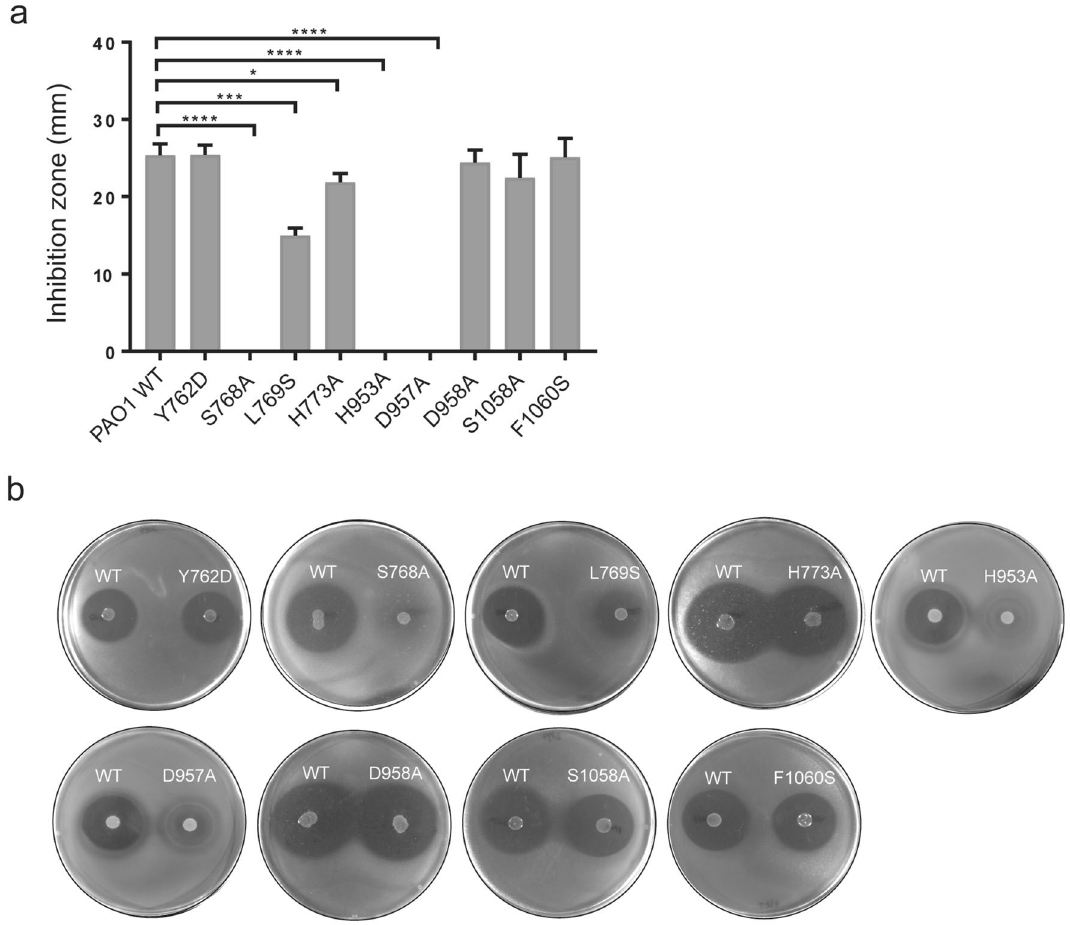
Figure 4. Plate inhibition assay for PAO1 WT and mutants against E. coli K12. ( a ) The diameter of zones of inhibition for PAO1 WT and mutants were measured using Image J software. Values are mean ± S.D (n = 3 independent samples). Any difference was considered significant at P value < 0.05 using t -test. * P < 0.0351; *** P < 0.006; **** P < 0.001. ( b ) In vivo AMB production results in zone of clearance around PAO1 WT or mutants due to growth inhibition of E. coli K12. PAO1 strains with Ser768A, His953A and Asp957A mutations showed no production of AMB, whereas PAO1 with Leu769S mutation exhibits significantly reduced AMB biosynthesis as compared to WT. AMB production was slightly significantly decreased for the mutant His773A. Tyr762D, Asp 958A, Ser1058A and Phe1060S showed no significant difference in AMB